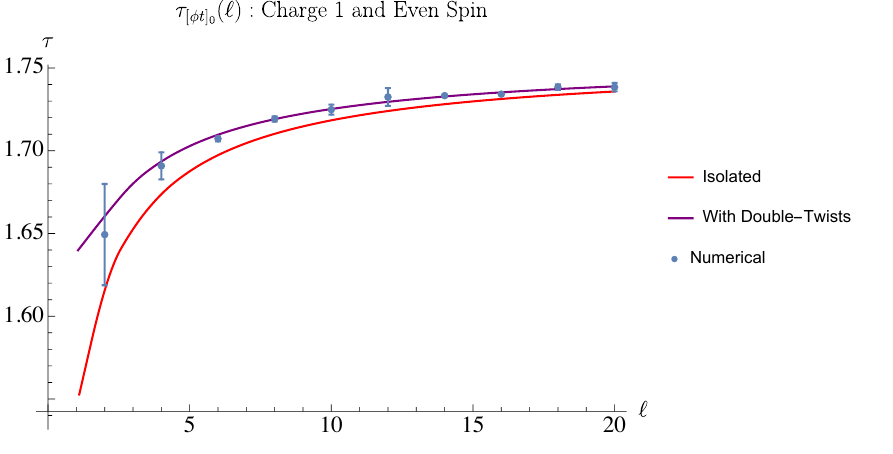
Figure 29 . The e(cid:11)ects of DTIs for low-lying double twists in the charge 1 [ (cid:30)t ] 1